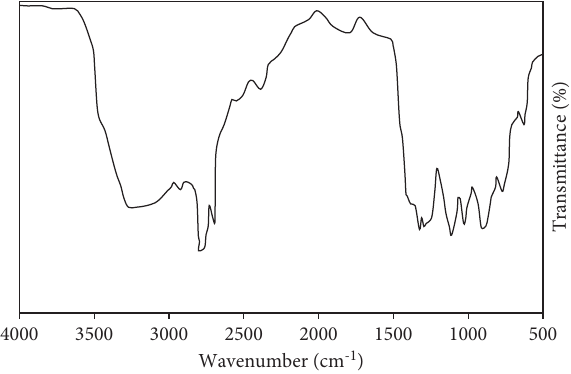
Figure 6: FTIR spectra of the liquid.